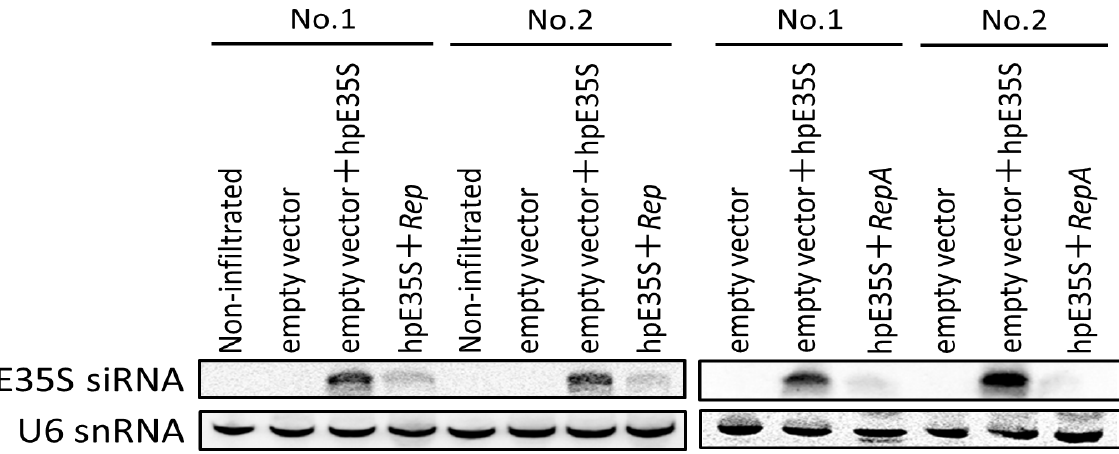
Figure 5. Analysis of E35S-specific siRNAs in non-infiltrated tissues and tissues infiltrated with empty vector or co-infiltrated with a mixture of two Agrobacterium transformants, one harboring hpE35S, and the other harboring either V, Rep , or RepA (top panel). Low molecular weight (LMW) RNA was isolated from infiltrated zones at 5 days post-infiltration and subjected to northern blot hybridization analysis. Two samples were prepared by pooling tissues from seven leaves. U6 snRNA served as the loading control (bottom panel).